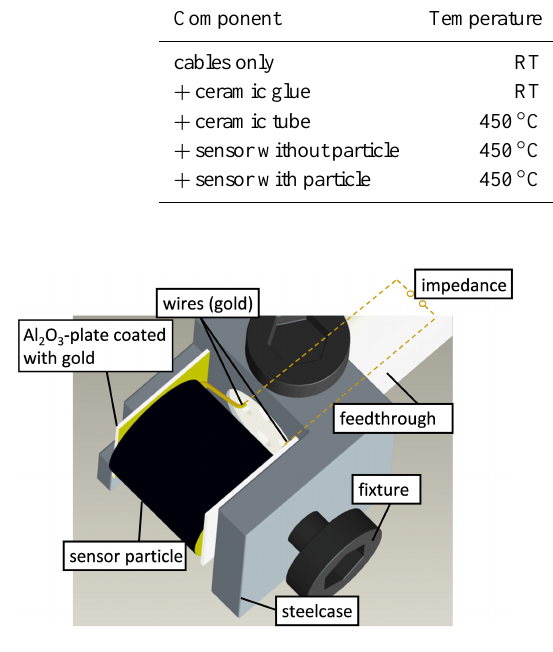
Figure 2. CAD drawing of the single-particle